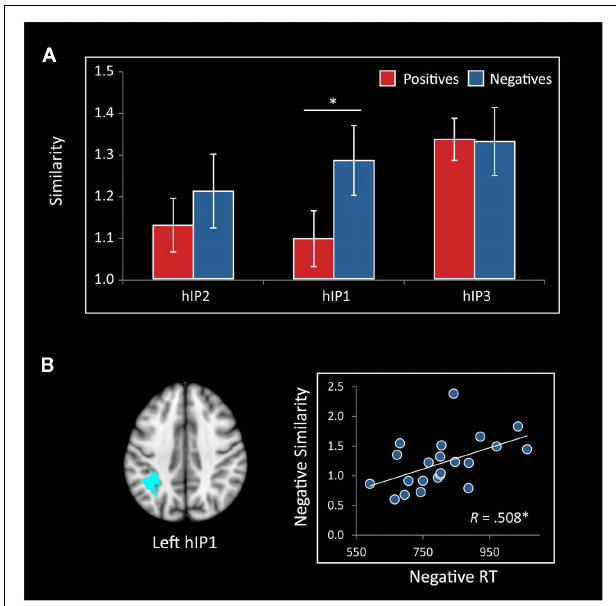
FIGURE 8 | Representational similarity in cyto-architectonically defined subdivisions of the IPS. (A) Representational similarity between near and far trials was greater for negative numbers than positive numbers bilaterally in hIP1 (* p = 0.027). Differences in hIP2 and hIP3 were not statistically significant ( p s > 0.2). (B) Representational similarity in the left hIP1 between near and far trials was correlated with reaction time (RT) on negative numbers (* p = 0.016), such that more distinct representations were associated with faster reaction